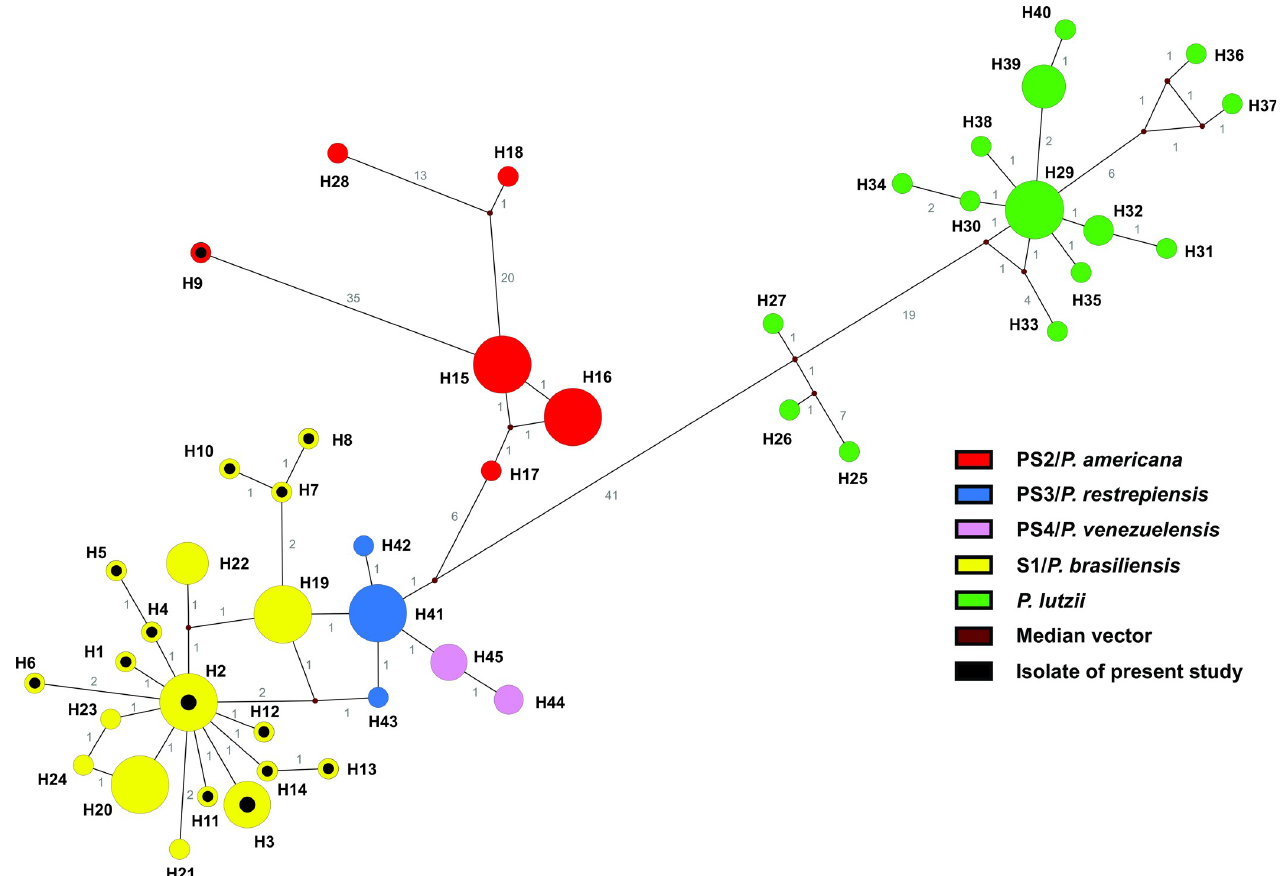
Fig 2. Median-joining haplotype network of 174 Paracoccidioides spp. based on concatenated nucleotide sequences of the loci GP43 + ARF. The especies are diferenciated by colors as follow: red PS2/ P . americana , blue PS3/ P . restrepiensis , pink PS4/ P . venenzuelensis , yellow S1/ P . brasiliensis and green P . lutzii . Each circle represents a unique haplotipe (H), and the circumference is proportional to haplotype frequency (H2: 55 isolates; H41:77: H29:14; H19: 7; H15: 8; H16: 7; H20: 8; H3: 5; H39: 4; H22: 4; H45: 3; H44: 2; H32: 2 and the remaining is composed by one isolate each). Brown dots (median vectors) are hypothetical missing